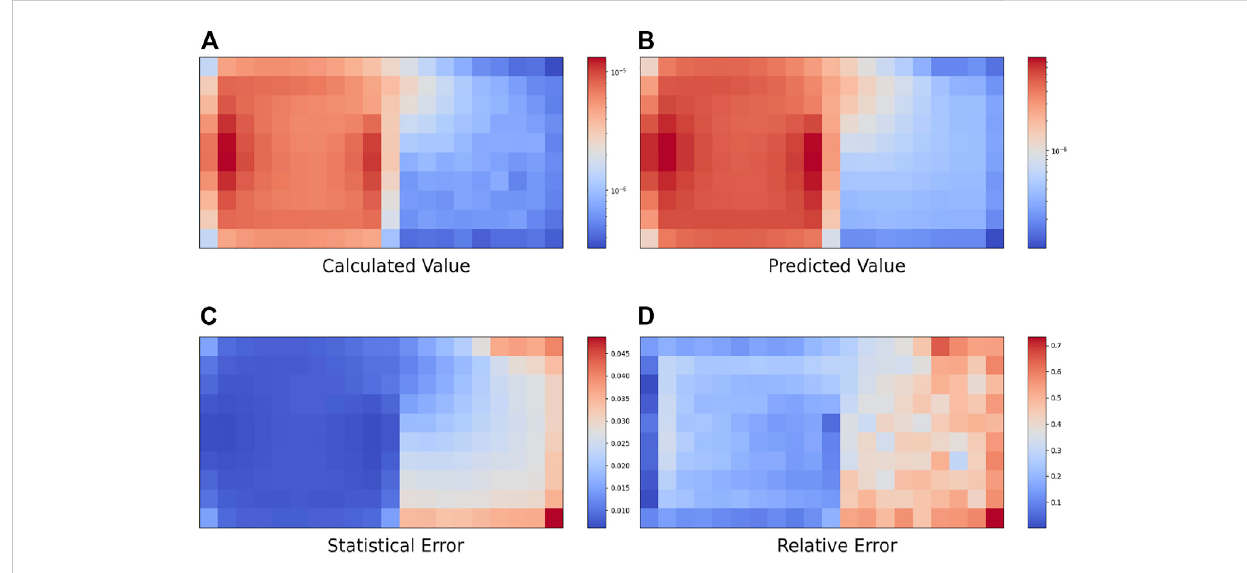
FIGURE 9 Reconstruction results of the maxwell source term.